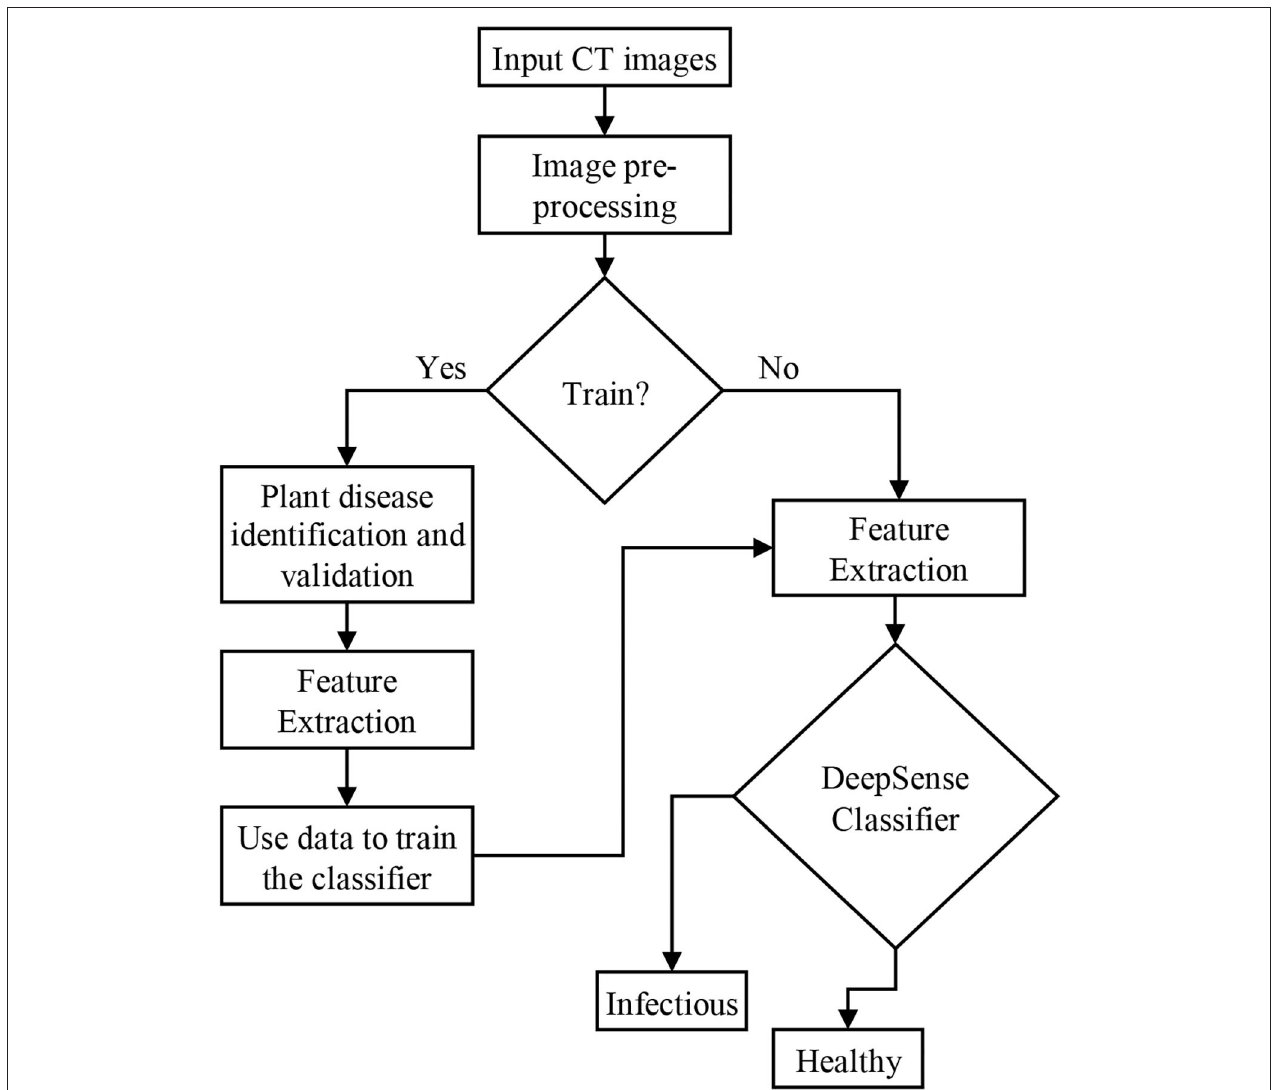
FIGURE 1 | Proposed model for